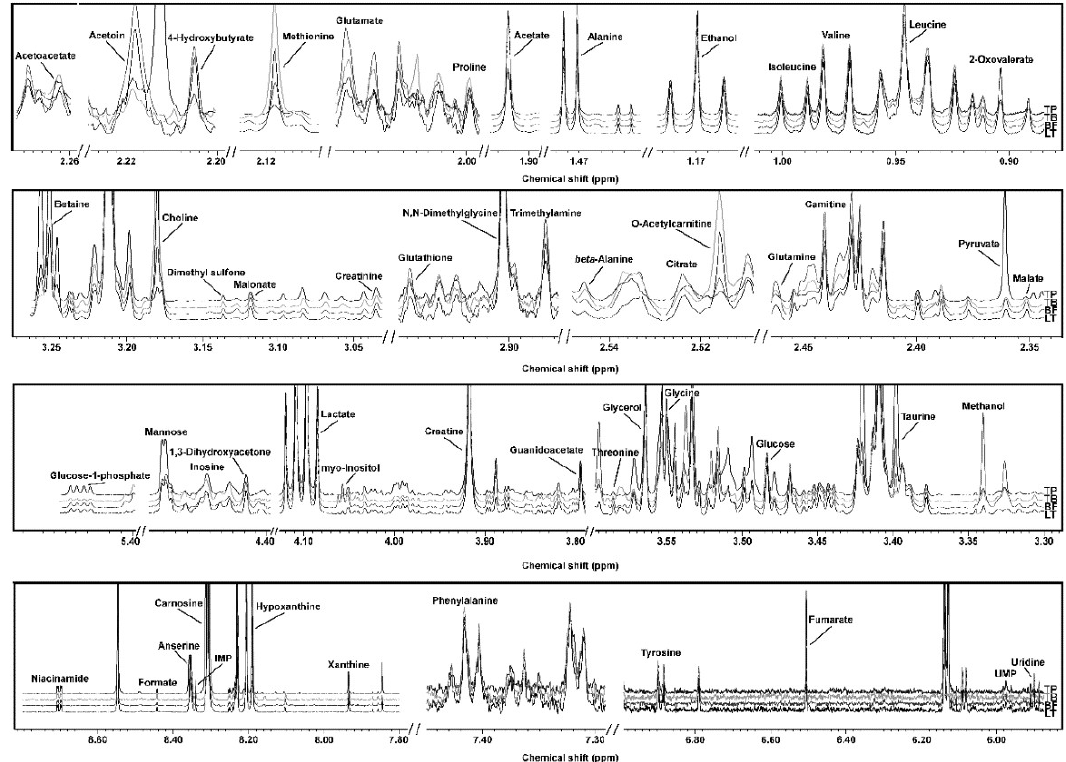
Figure 1. 1 H-NMR spectra from trapezius (TP), triceps brachii (TB), biceps femoris (BF) and longissimus thoracis (LT), representative of all the registered spectra. The name of each molecule appears over the signal used for its quantification. To ease the reader’s visual inspection, for each portion a spectrum with a convenient signal-to-noise ratio has been selected. The entire spectra and molecules identification is shown in Figures S2–S13.